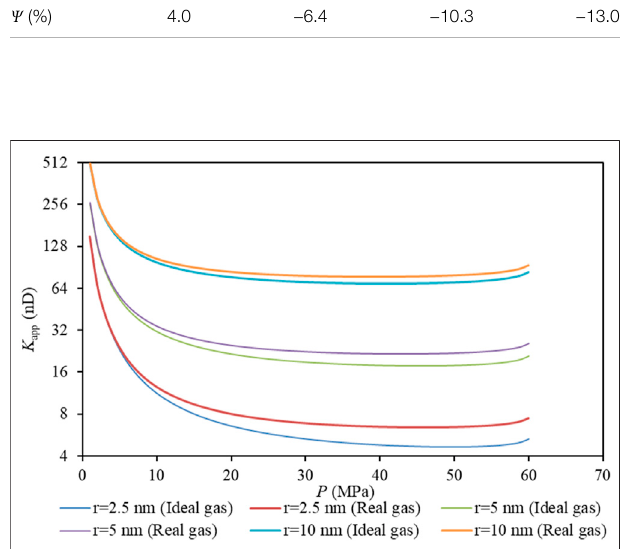
FIGURE 9 | Effect of ideal and real gas on the apparent permeability for different pore radii.